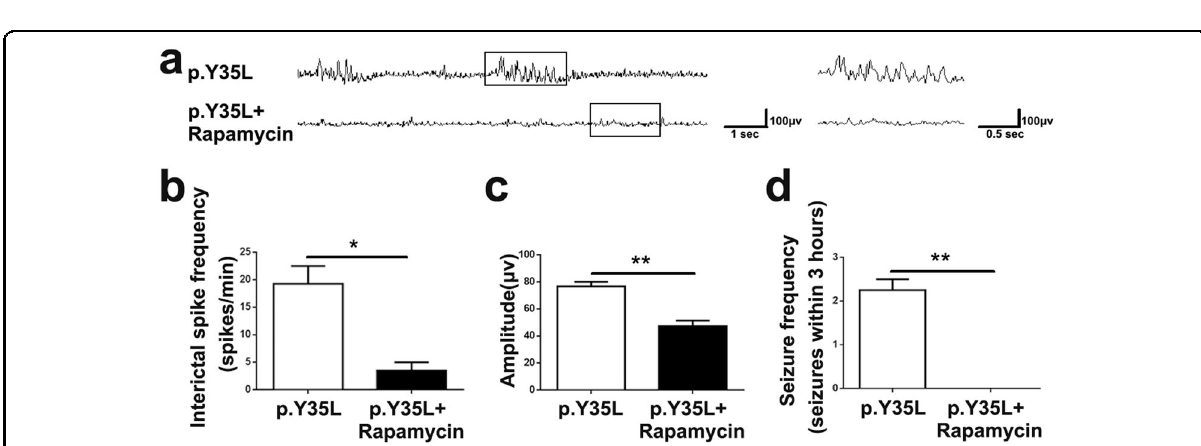
Fig. 5 Rapamycin treatment attenuates RHEB p.Y35L mutation-induced abnormal EEG and seizures. a One-and-half-month-old mice with embryonic expression of the p.Y35L RHEB plasmid were fi rst recorded for EEG, treated with rapamycin at 10 mg/kg for 11 days, and recorded for EEG again. The interictal spike frequency ( b ) and amplitude ( c ) of EEG in a were quanti fi ed for comparison. Data are presented as the mean ± s.e.m, n = 3, * P < 0.05, ** P < 0.01 (Student ’ s t -test). d The seizure frequency in p.Y35L RHEB-carrying mice was recorded over a 3-h-long period before and after rapamycin treatment for comparison. Data are presented as the mean ± s.e.m, n = 3, ** P < 0.01 (Student ’ s t